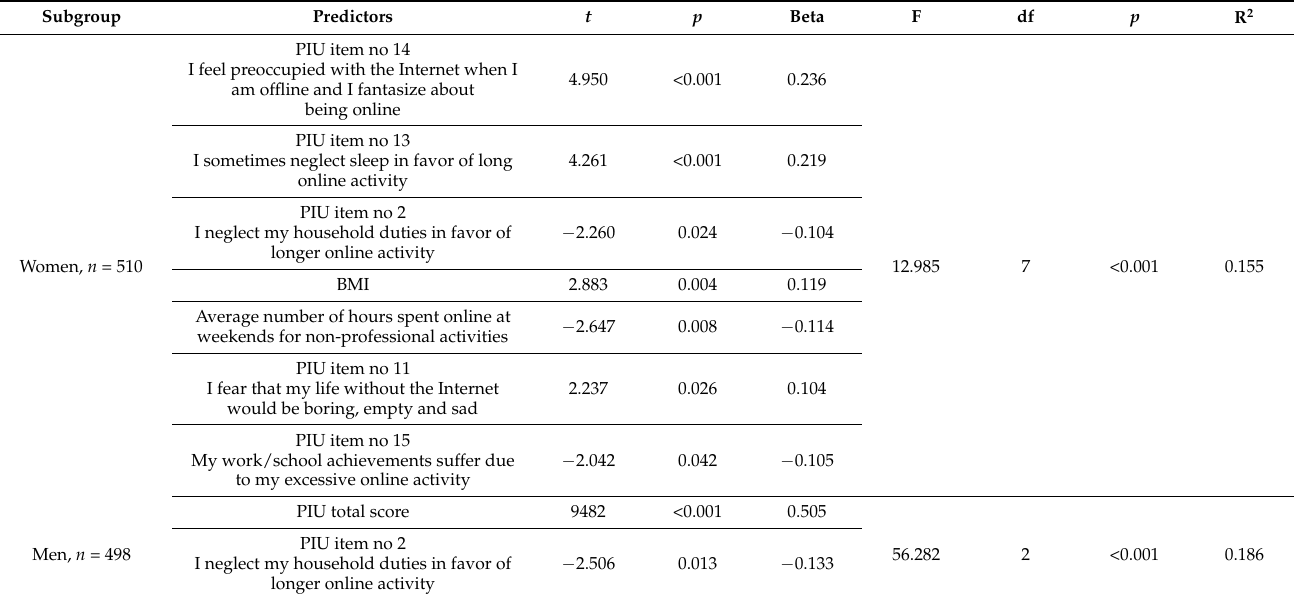
Table 3. Linear regression analysis of EAT-26 scores in men and women.